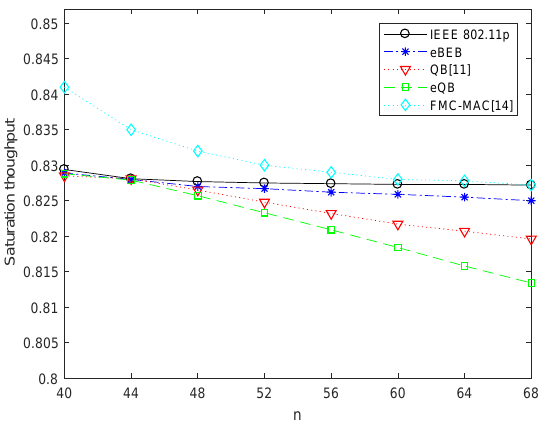
Figure 6. The saturated throughput.